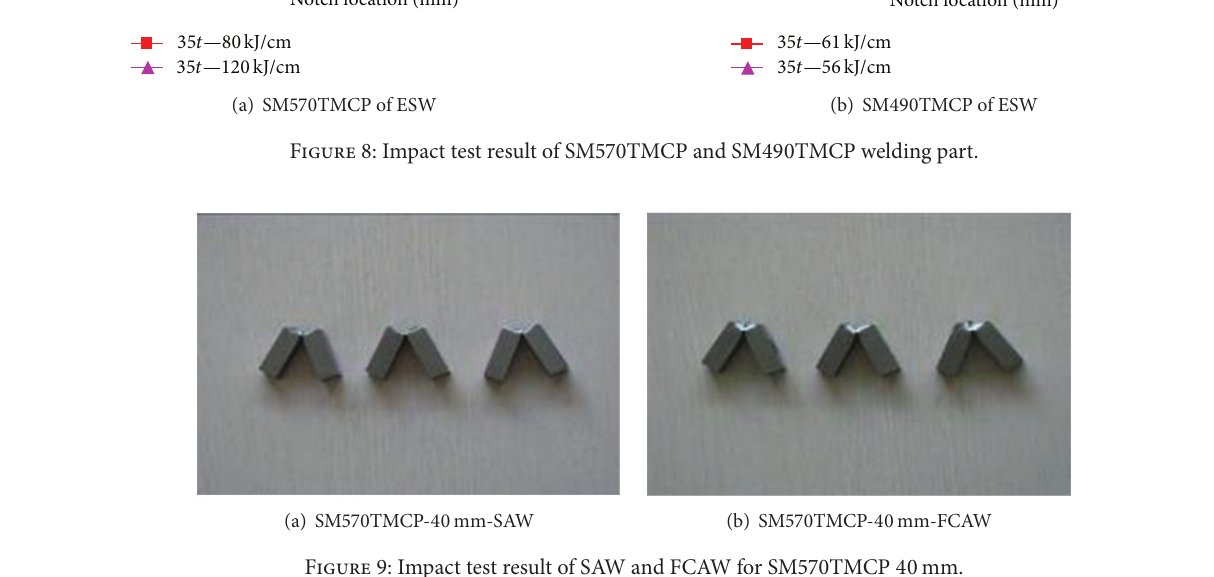
Figure 9: Impact test result of SAW and FCAW for SM570TMCP 40 mm.